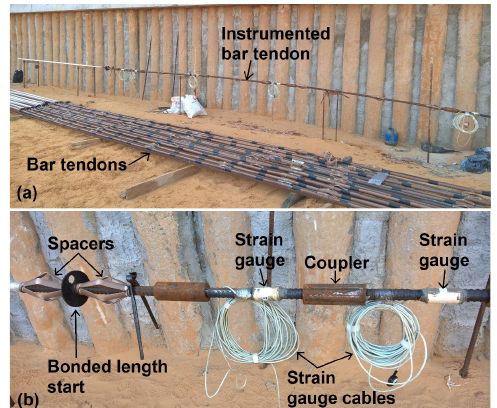
Figure 8 - (a) Bar tendons used in the field; (b) Detail of an instrumented bar tendon.